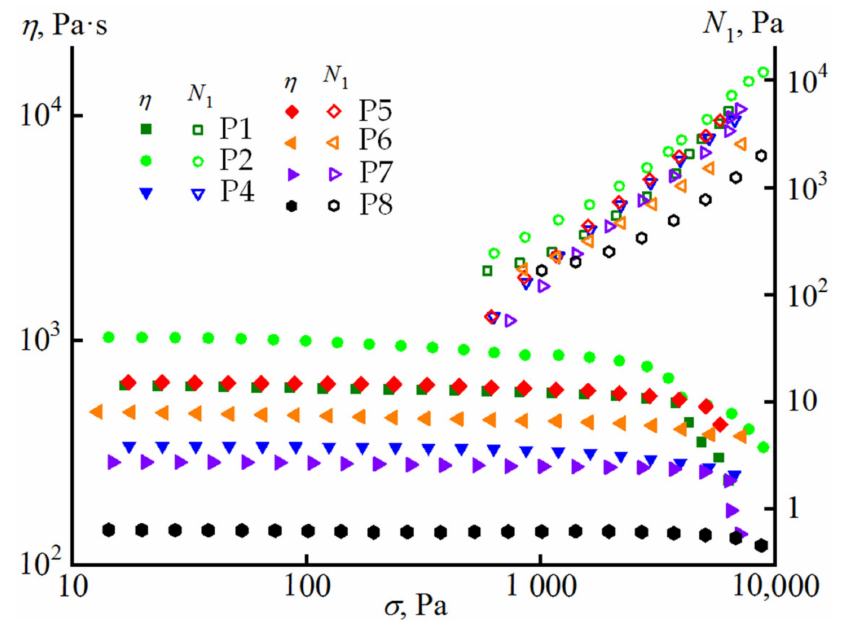
Figure 4. Shear stress dependences of the effective viscosity and the first normal stress difference at 190 ◦ C. The polymer numbers are presented in the